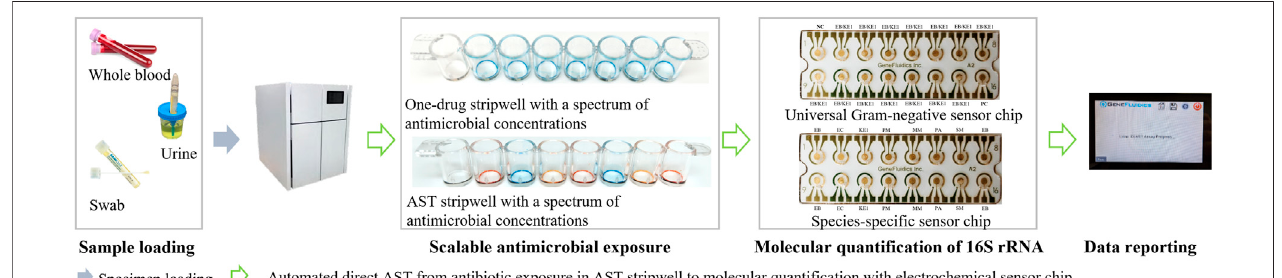
FIGURE 2 | Work fl ow of the presented direct-AST. The user loads specimens and consumables (stripwell and sensor chip), selects specimen type, and waits for susceptibilityreporting(userinterventioninbluearrows).Thesystemisdesignedtoautomatescalableantimicrobialexposureandmolecularquanti fi cation(greenarrows) for AST reporting directly from whole blood or